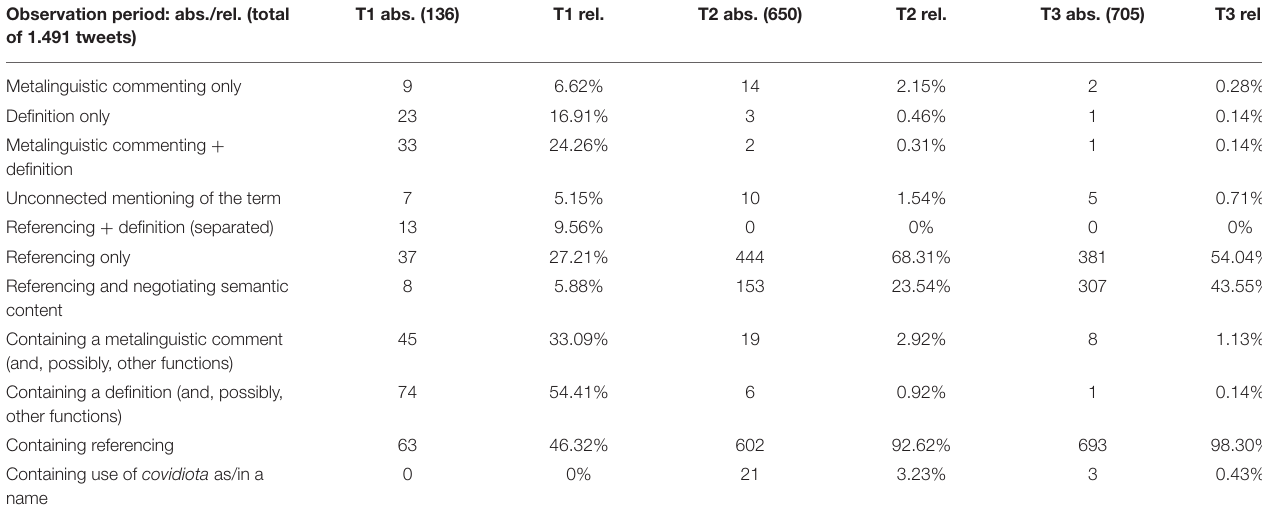
TABLE 7 | Metalinguistic use, defining, referencing and combination of functions. Observation period: abs./rel. (total of 1.491